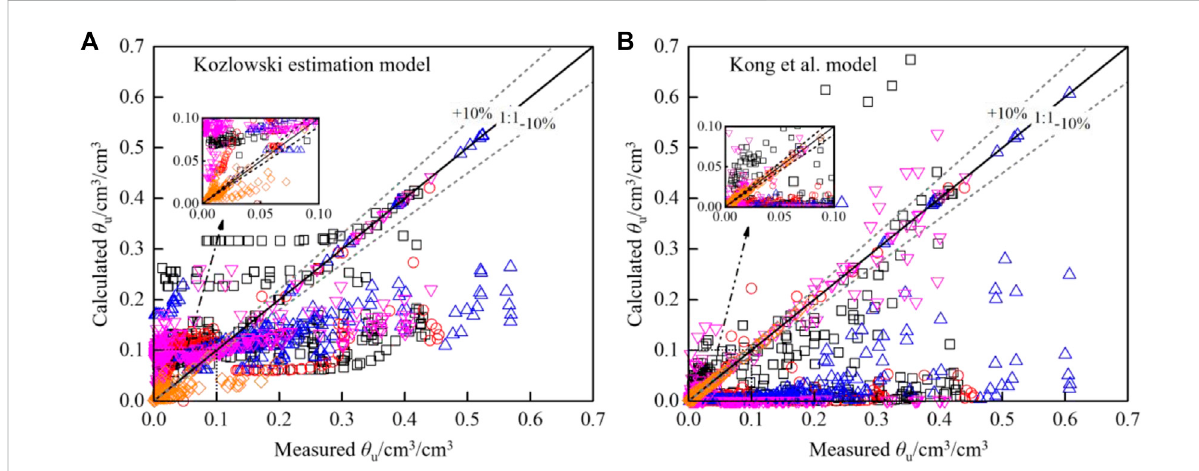
FIGURE 4 Calculatingperformanceof2estimationmodels.Inthe fi gure,blacksquarestandsforclay,blueuptrianglestandsforsiltyclay,redcirclestands for silt, magenta down triangle stands for sand, and orange rhombus stands for